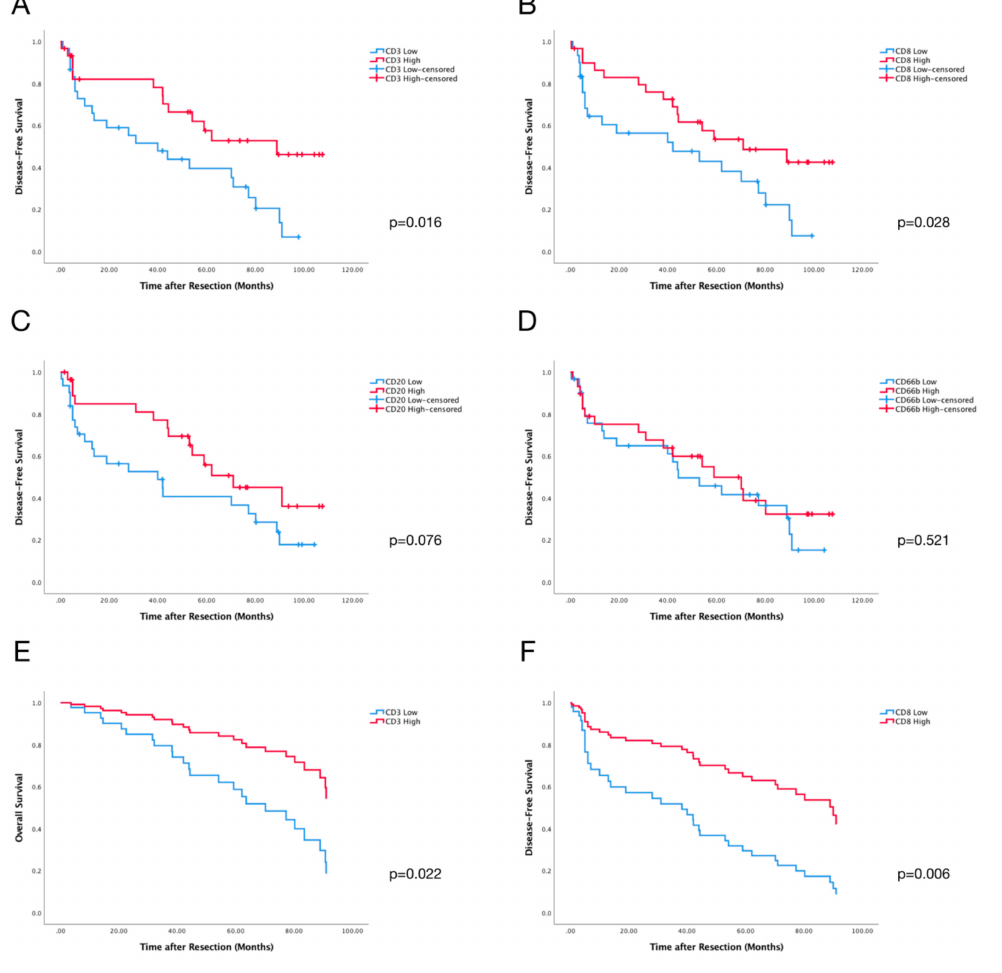
Figure 3. Kaplan-Meier Curves of CD3 + ( A ), CD8 + ( B ), CD20 + ( C ), and CD66 + ( D ) cells for DFS. ( E ) Cox Regression Curves of CD3 + cells on OS (Overall Survival) with Collett’s Model for Selection of Covariates. ( F ) Cox Regression Curves of CD8 + cells on DFS (Disease Free Survival) with Collett’s Model for Selection of